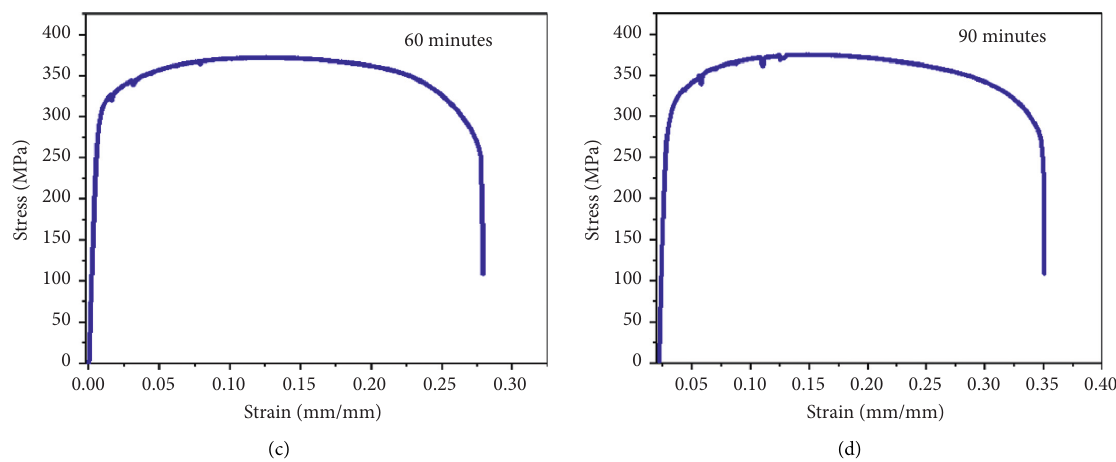
Figure 5: Stress-strain curve graph of different samples: (a) parent, (b) 30min, (c) 90 min, and (d) 60min.